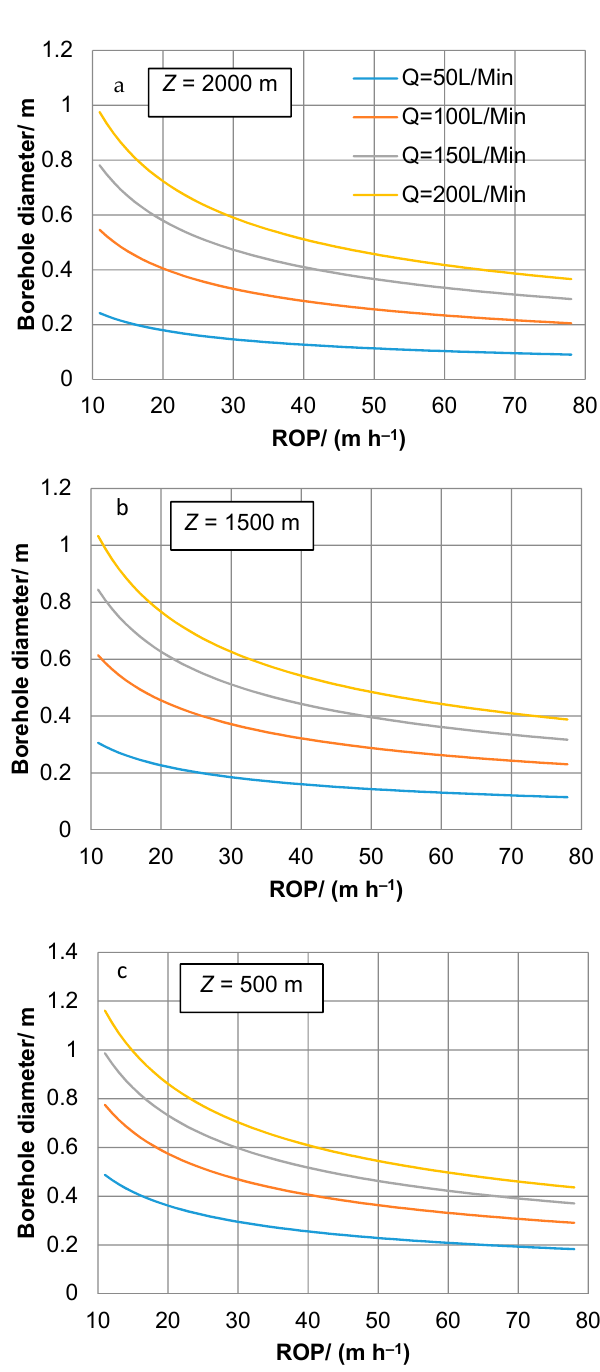
Figure 8. Mean borehole diameter vs. ROP at different target depths ( a , 2000 m; b , 1500 m; c , 500 m) and flow rates ( b = 11 mm, d h = 38 mm, k = 0.3 J s − 1 m − 1 K − 1 , T i = − 20 °C, and C w = 4190 J kg − 1 K − 1 )